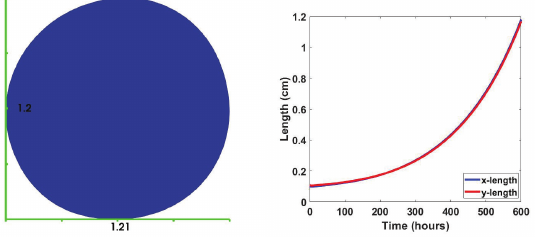
Figure 8. Dimensions of the tumor subject to immune cells influx at t = 600 h. The curves show the time evolution of the bounding box